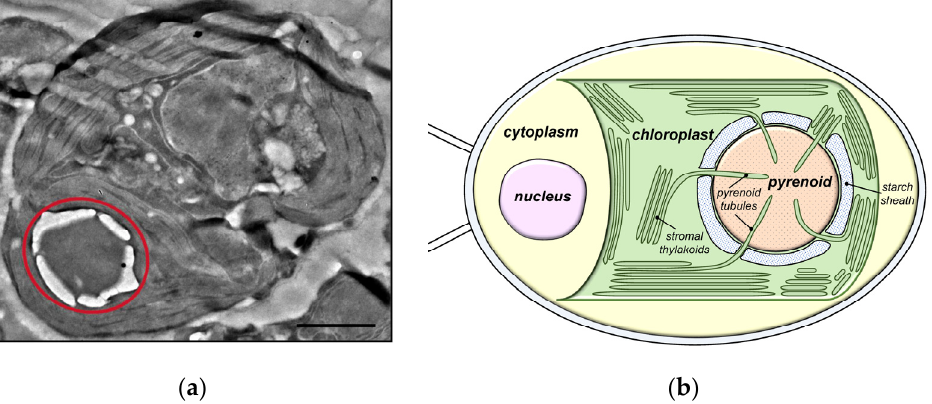
Figure 6. Pyrenoid in C. reinhardtii cells. ( a ) The TEM image showing the pyrenoid inside the chloroplast of Chlamydomonas was kindly provided by Dr. Maria A. Sinetova (K.A. Timiryazev Institute of Plant Physiology, RAS, Moscow). Scale bar is 1 µm. ( b ) Schematic cross-sectional view of a Chlamydomonas cell showing the branching of cylindrical pyrenoid tubules from the thylakoid stacks and their entrance into the pyrenoid matrix through fenestrations in the starch sheath.